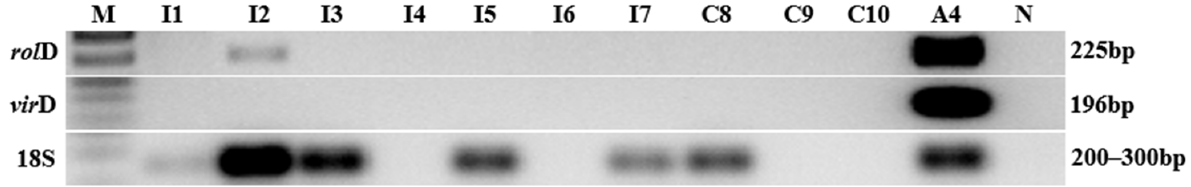
Figure 9. Molecular analysis from the root samples. PCR using rol D, vir D, and 18S primer sets; Length of the PCR products are shown; M: 100 bp DNA ladder; I1–7: root samples extracted from inoculated seedlings; C8–10: root samples extracted from control seedlings; A4: positive control with DNA from the A4 strain of R. rhizogenes ; N: negative control with water.